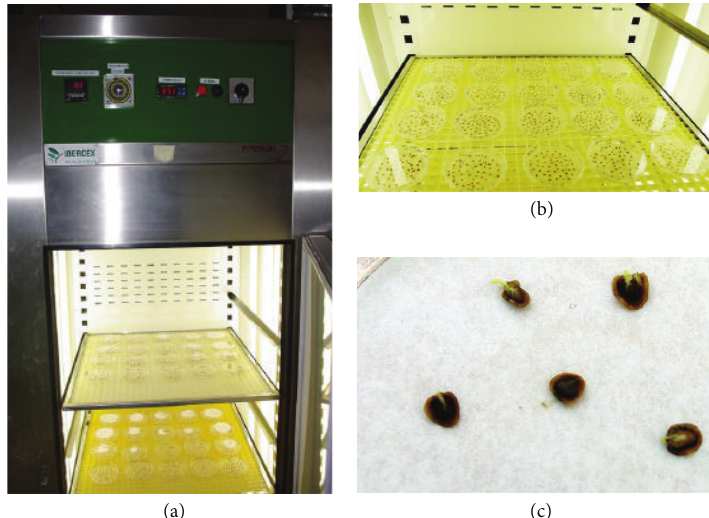
Figure 3: Petri dishes germination assay of G. lutea L. var. aurantiaca : (a) growth chamber; (b) Petri dishes distribution; (c) germinated seeds.